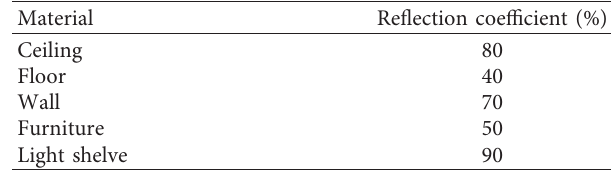
Table 4: Material reflection coefficient